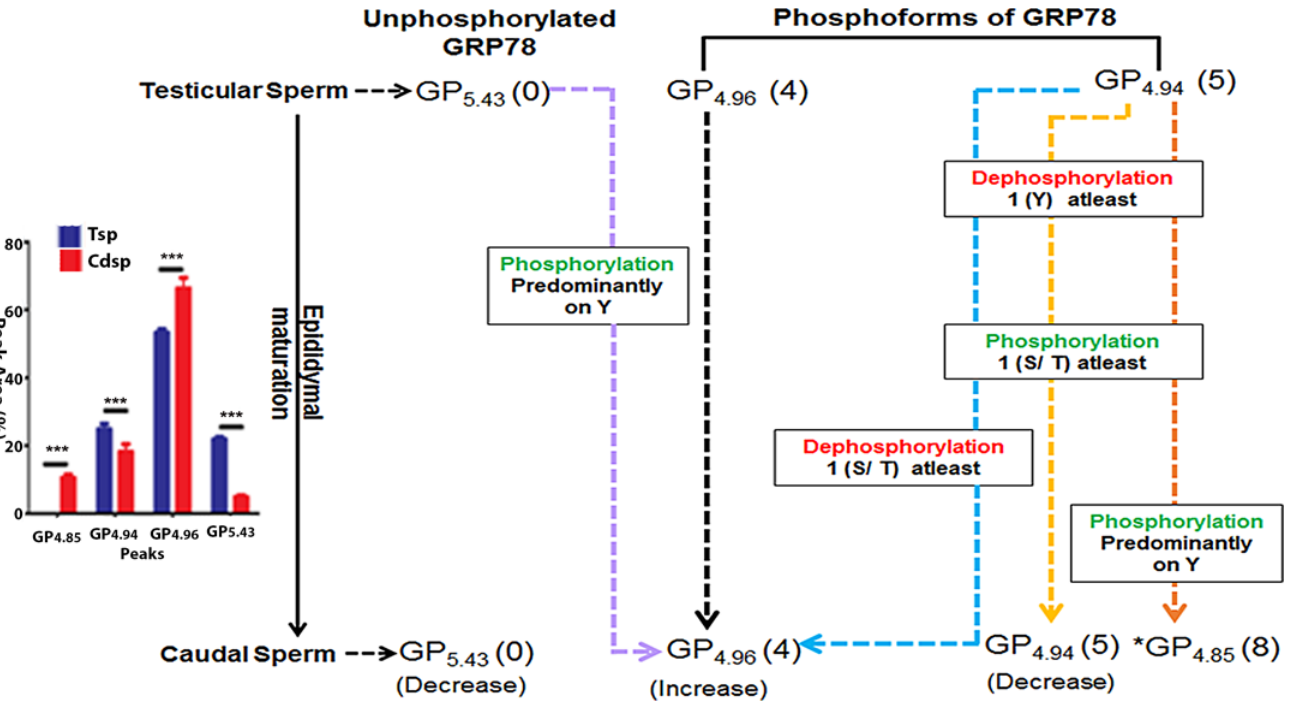
Fig 8. Phosphorylation changes in GRP78 during sperm maturation Immature testicular sperm are known to undergo structural and functional maturation in the epididymis. 2 phosphorylated forms of GRP78 were observed in testicular (immature) sperm (GP 4.94 and GP 4.96 ) and 3 phosphorylated forms in caudal (mature) sperm (*GP 4.85, GP 4.94 and GP 4.96 ). ‘ * ’ represents phosphorylated form of GRP78 exclusive to rat caudal sperm. Based on NIA profile and responses of rat testicular- and caudal — sperm GRP78 to phosphatases λ - PP and CIP, we hypothesize putative phosphorylation/ dephosphorylation changes in sperm GRP78 as the sperm traverses from the testis to caudal region of the epididymis and attains maturity. Testicular sperm represents immature sperm while the caudal sperm represents mature sperm. The remarkable changes are as